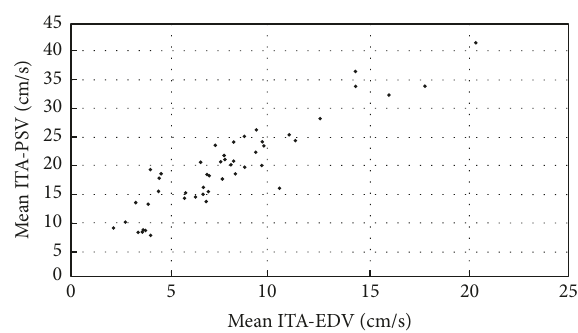
Figure 3: Scatterplot showing the relationship between the mean ITA-EDV (cm/s) and mean ITA-PSV (cm/s): 𝑟 = 0.919 ; 𝑃 < 0.001 .